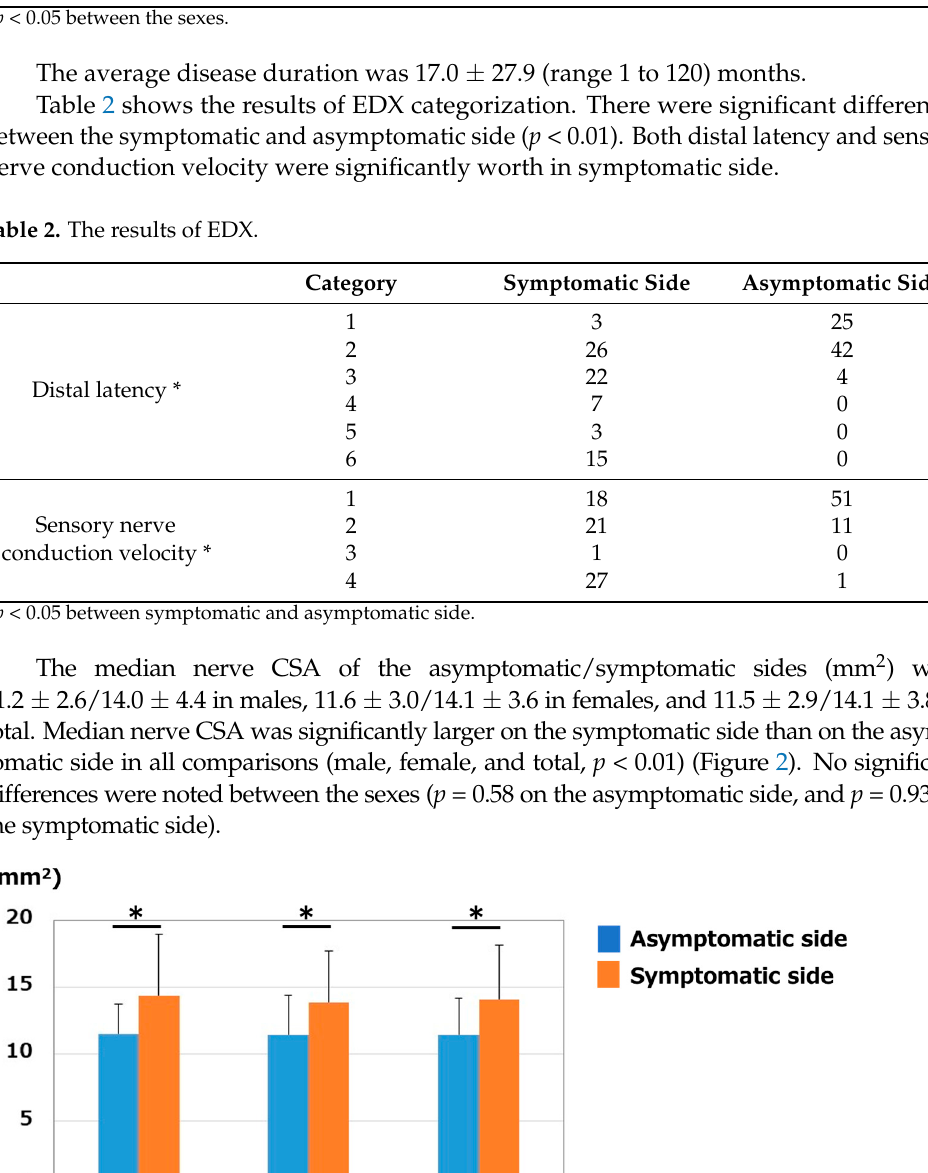
Figure 3. Relationships between height and CSA. ( A ) Asymptomatic side. ( B ) Symptomatic side. The relationships between body weight and CSA are shown in Figure 4. Correlation coefficients were 0.39 on the asymptomatic side and 0.18 on the symptomatic side. Weight medium correlated with CSA on the asymptomatic side only ( p < 0.05). Figure 4. Relationships between weight and CSA. ( A ) Asymptomatic side. ( B ) Symptomatic side. The relationships between BMI and CSA are shown in Figure 5. Correlation coeffi- cients were 0.44 on the asymptomatic side and 0.18 on the symptomatic side. On the asymptomatic side, correlation coefficients between BMI and CSA by sex were 0.40 in males and 0.46 in females. BMI medium correlated with CSA on the asymptomatic side in both sexes ( p < 0.05); slightly stronger in females than in males. H e i g h t ( c m )